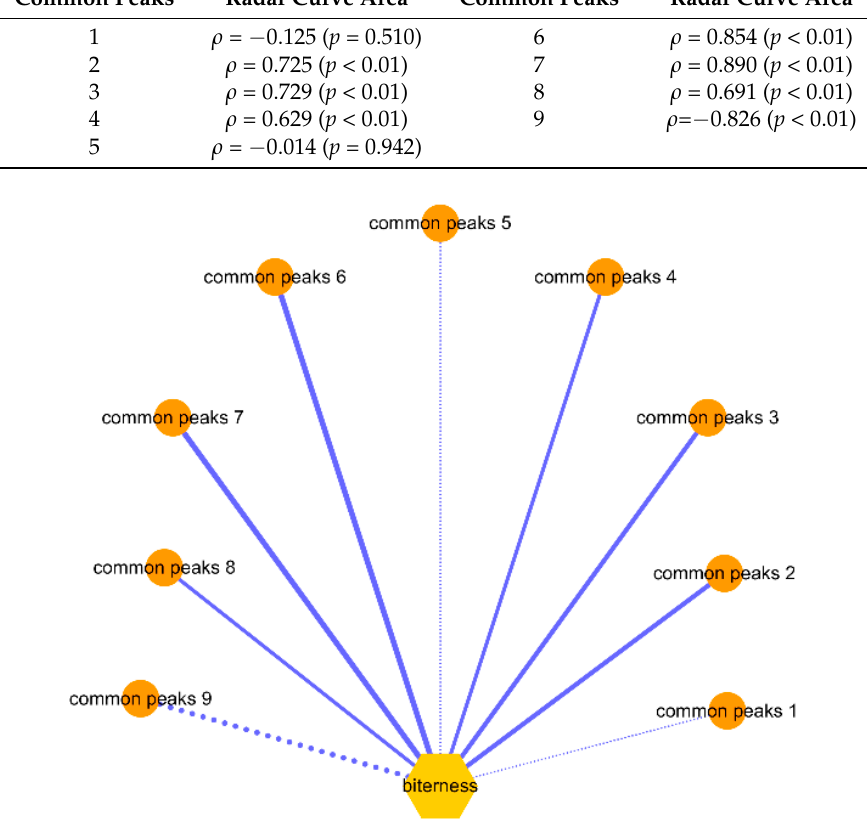
Table 2. Correlation Coefficients between bitter (radar curve area) and the common peaks in HPLC fingerprint. Common Peaks